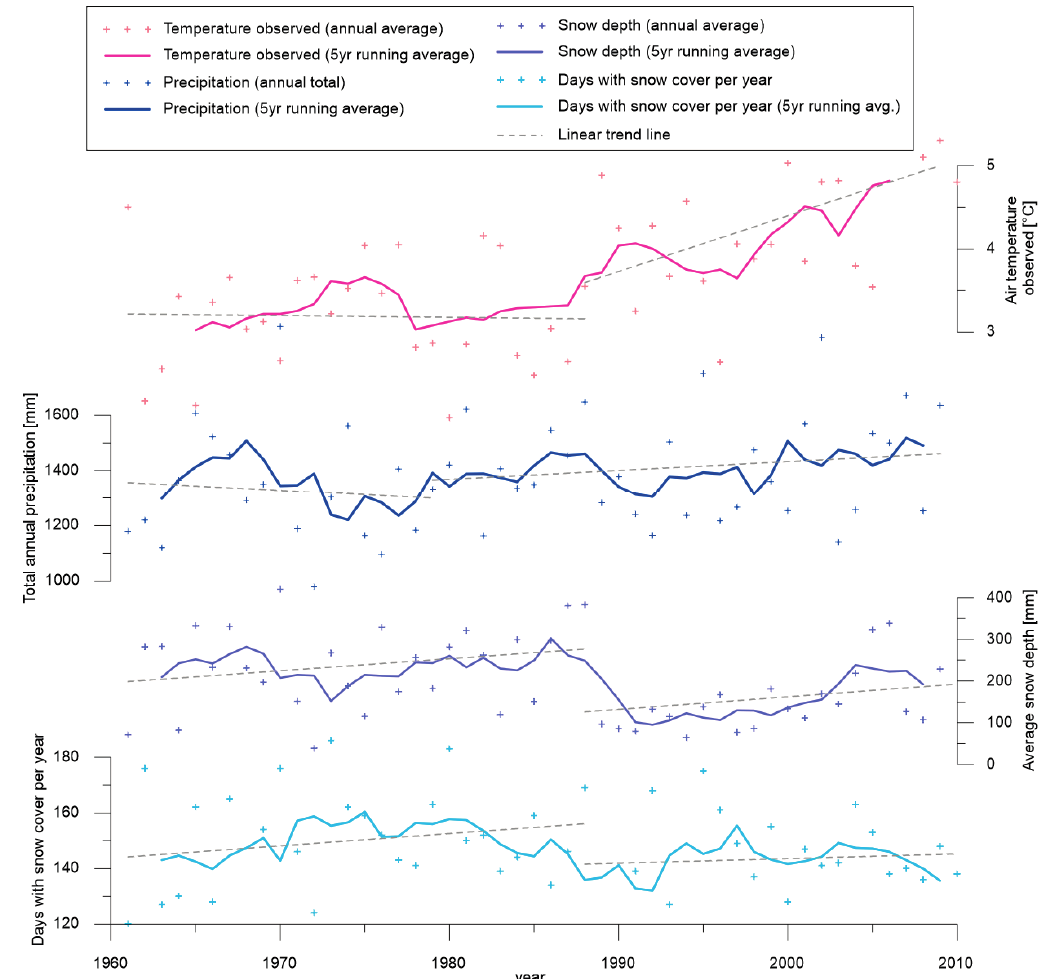
Figure 3. Observed climatic conditions during